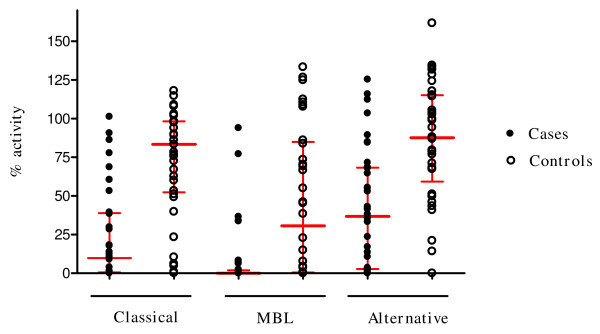
Aligned dot plot showing median and interquartile % functional activity in each complement pathway in children with severe malaria anaemia (cases) and those with uncomplicated malaria (controls). The median functional activity in cases was significantly reduced compared to the controls (9.9% vs 83.4% for CP, 0.09% vs 30.7 for MBL and 36.8% vs 87.7% for AP respectively, P < 0.001). Wilcoxon matched-pairs signed-ranks test was performed with the 36 paired samples.